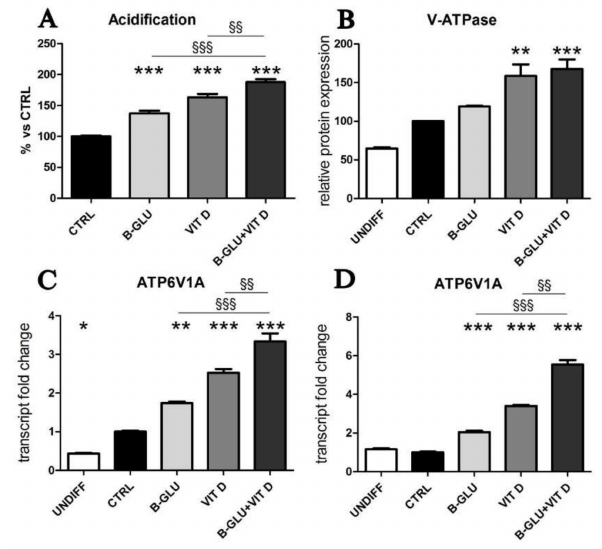
Figure 2. Vitamin D and beta-glucans stimulate vesicular acidification. The two cell lines were differentiated to macrophages by TPA treatment or used as undifferentiated monocytes and were analyzed after 24 h of treatment with 100 µ g/mL beta-glucans (B-GLU) and 100 nM vitamin D (VIT D). ( A ) In differentiated U-937 cells, acidification was measured as neutral red accumulation; ( B ) in undifferentiated (undiff) and differentiated and treated U-937 cells the levels of V-ATPase protein expression were evaluated by Western blotting; the transcription of subunit A of the V 1 domain of V-ATPase (ATP6V1A) was quantified by real-time PCR in undifferentiated (undiff) and differentiated and treated cells: ( C ) U-937 cells and ( D ) THP-1 cells. Results are expressed relative to control and as the means ± SEM. * P < 0.05, ** P < 0.01 and *** P < 0.001 vs. ctrl; §§ P < 0.01 and § §§ P <